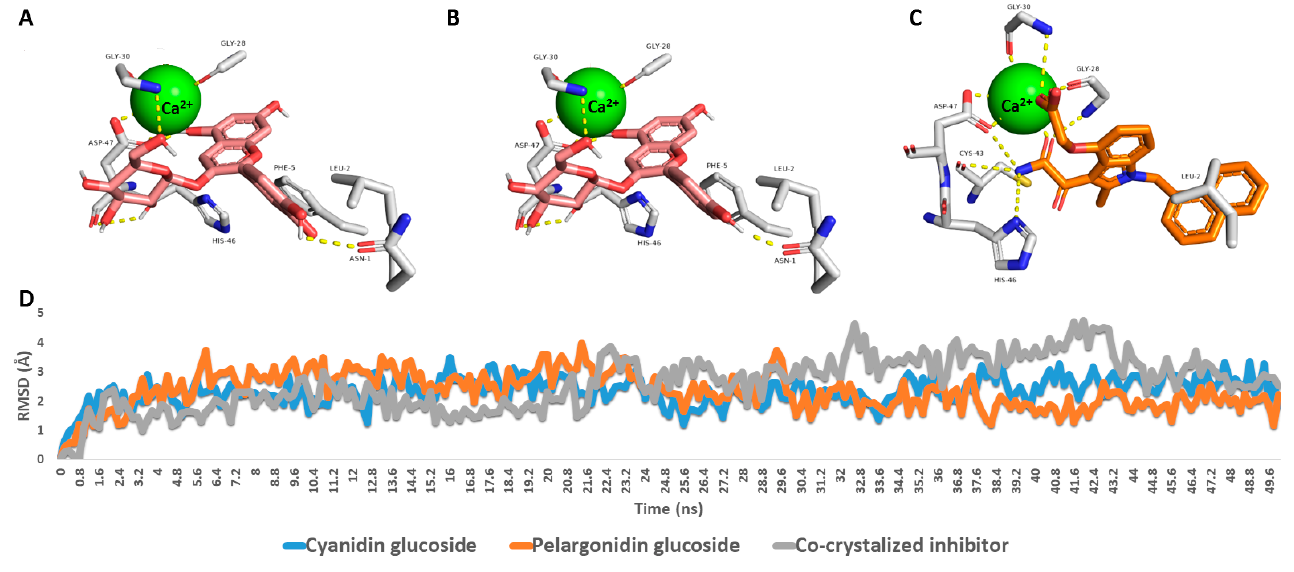
Figure 11. ( A – C ) Binding modes of the MDS ‐ derived most populated poses of both cyanidin and pelargonidin glucosides along with the co ‐ crystalized inhibitor (i.e., 7w9) inside human PLA2’s active site (PDB ID: 5WZS). ( D ) RMSDs of both cyanidin and pelargonidin glucosides along with the co ‐ crystalized inhibitor over the course of 50 ns ‐ long MDS runs.